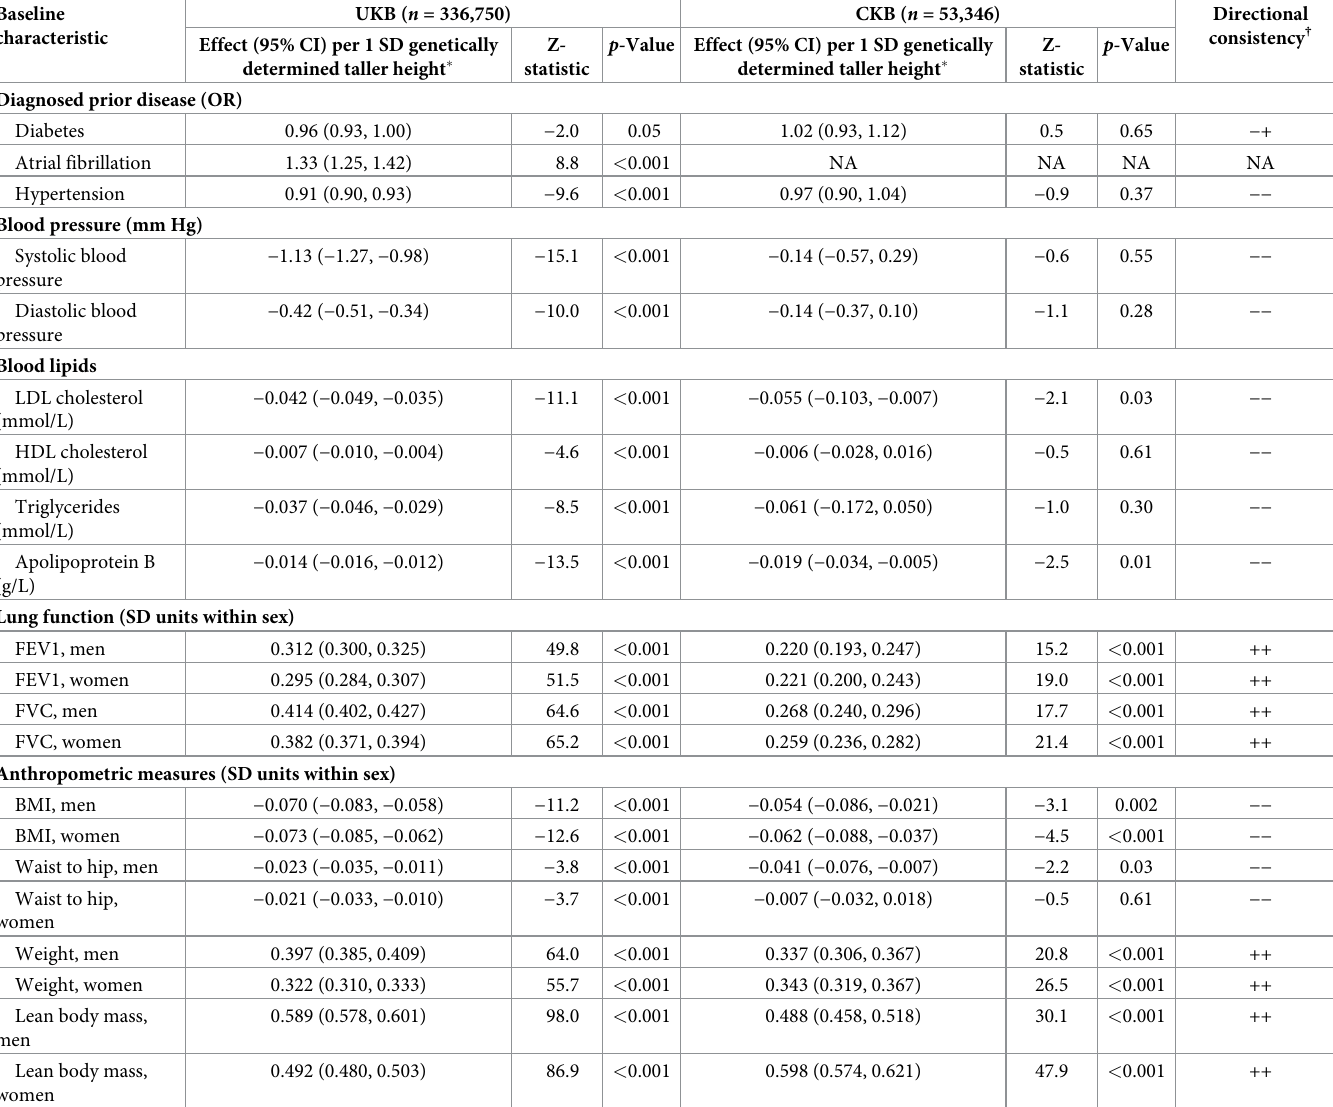
Table 1. Associations of genetically determined height with cardiovascular risk factors and anthropometric traits in UKB and CKB. Baseline